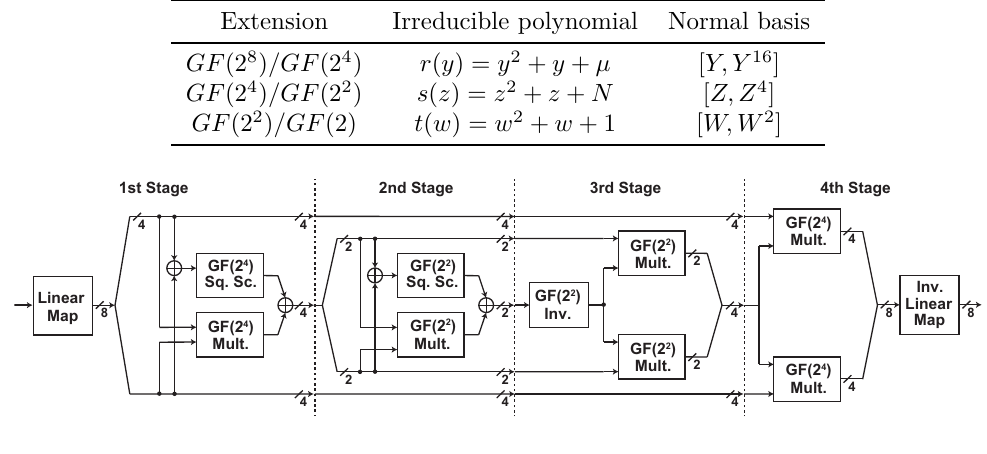
Figure 2: Inversion over GF (2 8 ) in four